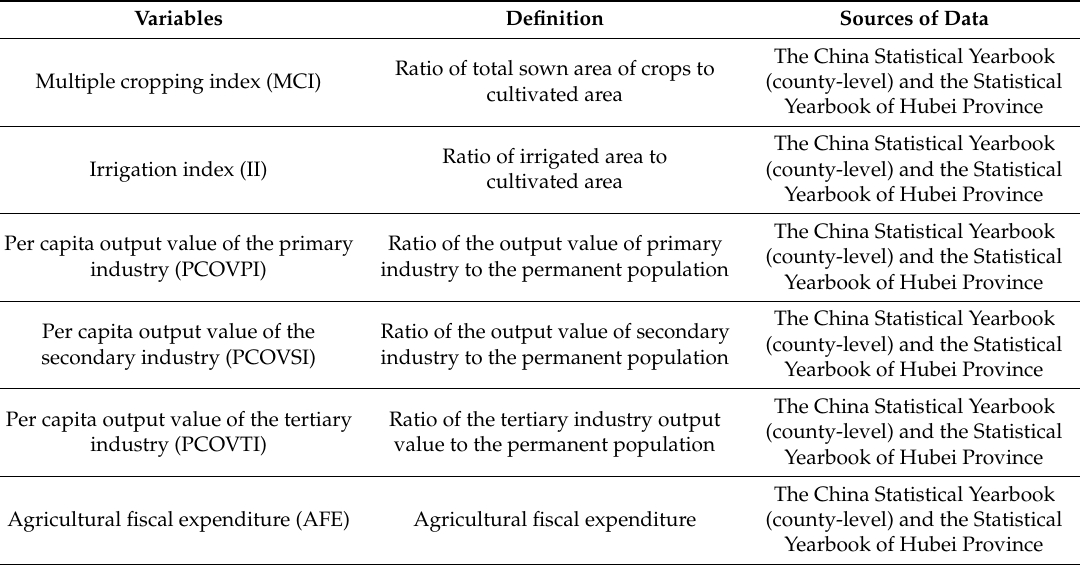
Table 2. The Driving Factors of Agricultural Land Use